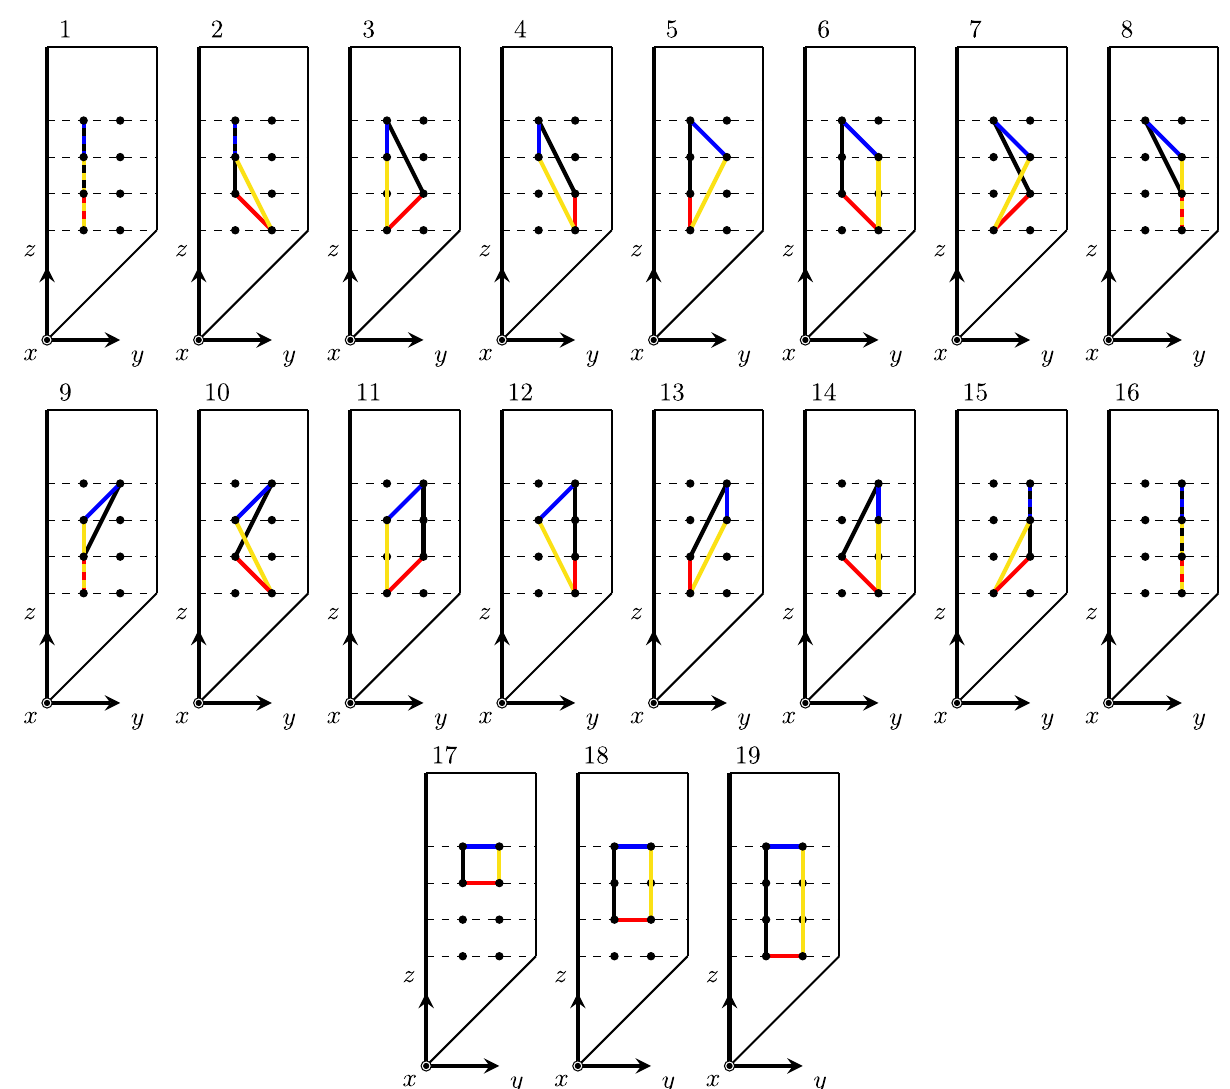
Figure 4. Configurations 1 to 19. In blue, distance for V ++ . In red, distance for V −− . In yellow, distance for V V +− . In black, distance for −+